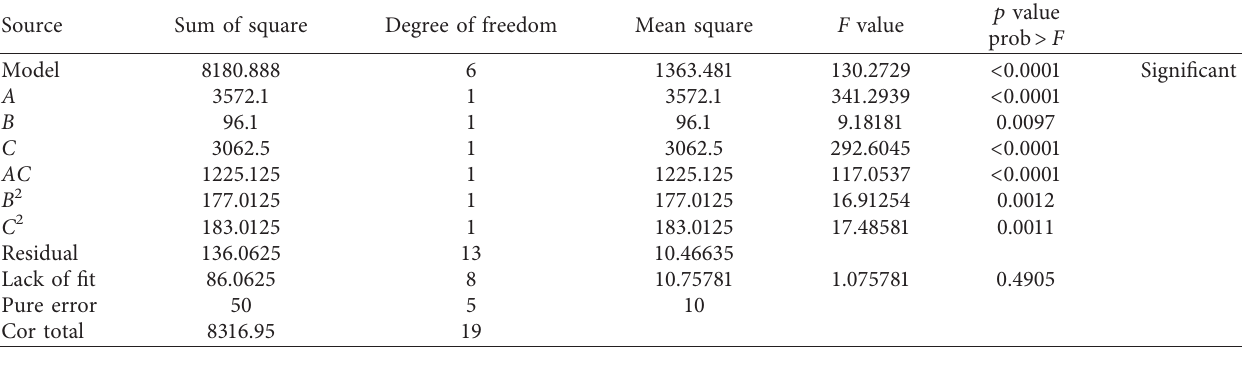
Figure 4: Residual plot for COF (a) Normal probability plot. (b) Residual versus run number. (c) Residuals versus predicted values. Table 3: ANOVA for WML.